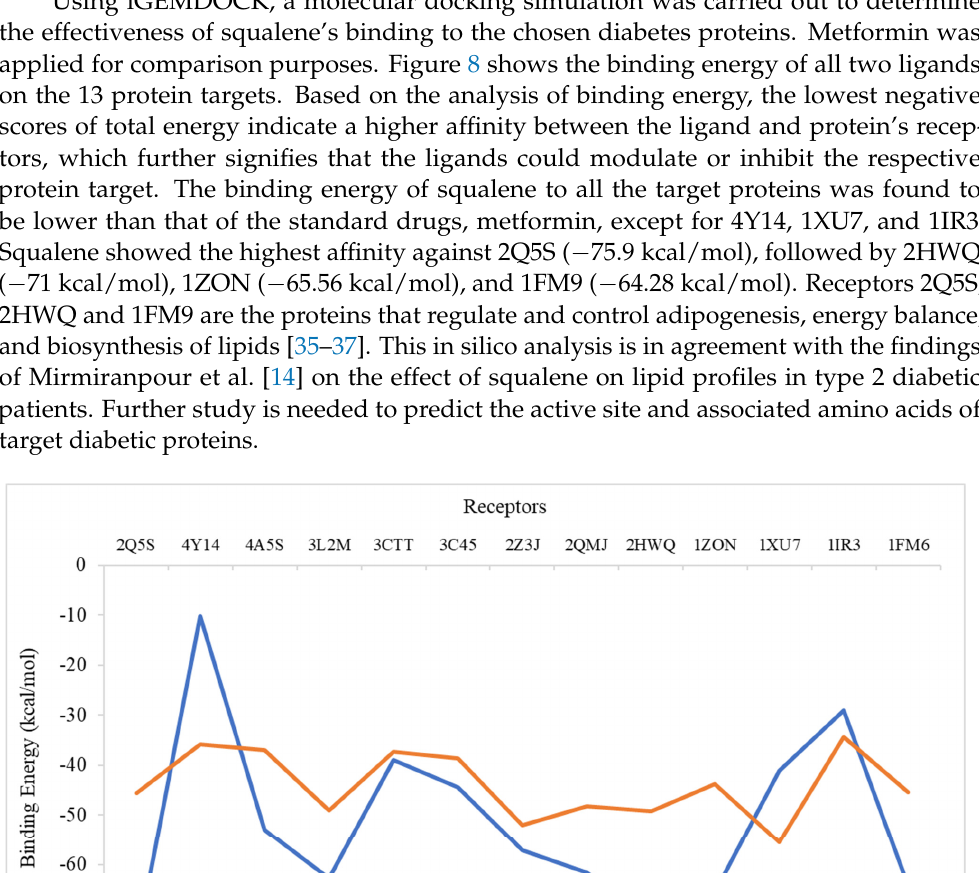
Figure 7. ( A ) Percentage of the immunostained area of each treated group and ( B ) Concentration of serum insulin of each treated group. NC, normal control (saline, 10 mL/kg); M, metformin (500 mg/kg); DC, diabetic control (saline, 10 mL/kg); ME, methanol extract (1 g/kg); CF, chloroform fraction (500 mg/kg); SF-1, n -hexane fraction (250 mg/kg); SQ, squalene (160 mg/kg). The values are expressed as mean ± SEM ( n = 6). * indicates significant differences as compared to the NC. # indicates significant differences compared to the DC (*** p < 0.001 and # p < 0.05) as analyzed using Dunnett as post hoc test.